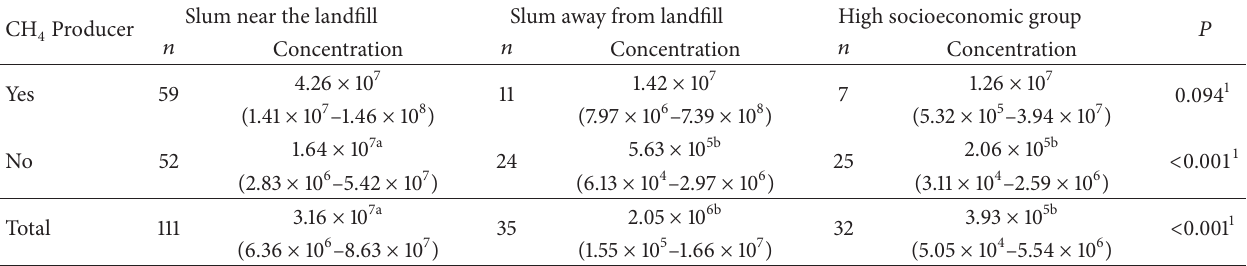
production in the three distinct 4